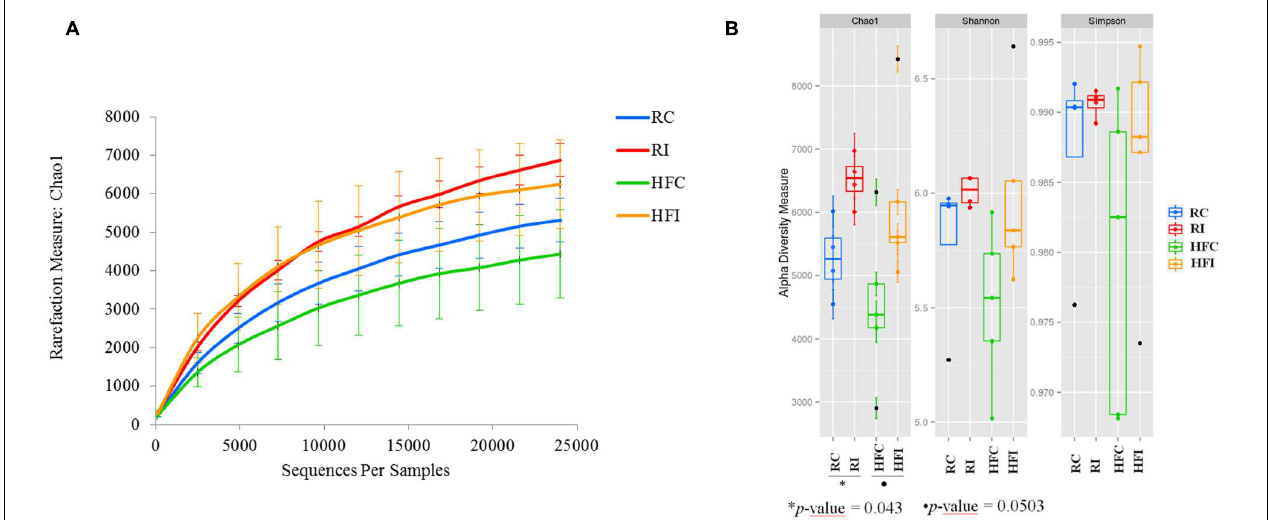
FIGURE 2 | Cecal content diversity analysis. (A) Cecal content microbiota rarefaction curve generated using Chao1 richness estimator. Samples have been rarified at an even depth of 24,500 sequences per sample. Error bars indicate the 95% confidence intervals. (B) Cecal content alpha-diversity; richness (Chao1) and diversity (Shannon and Simpson) indices box plot.